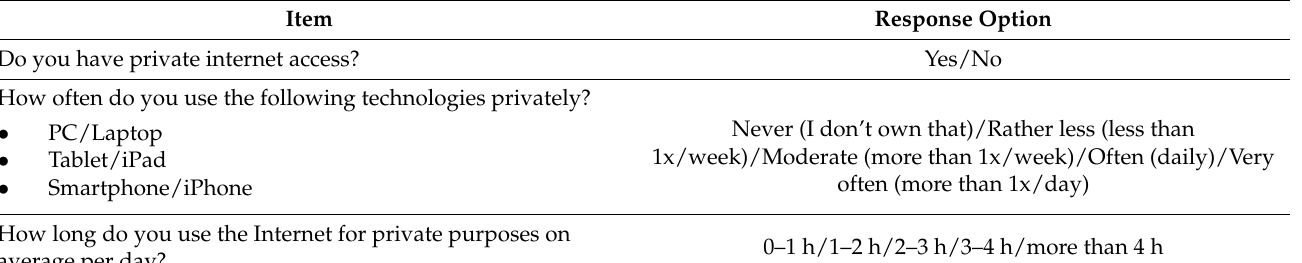
Table A1. Self-generated eHealth items.